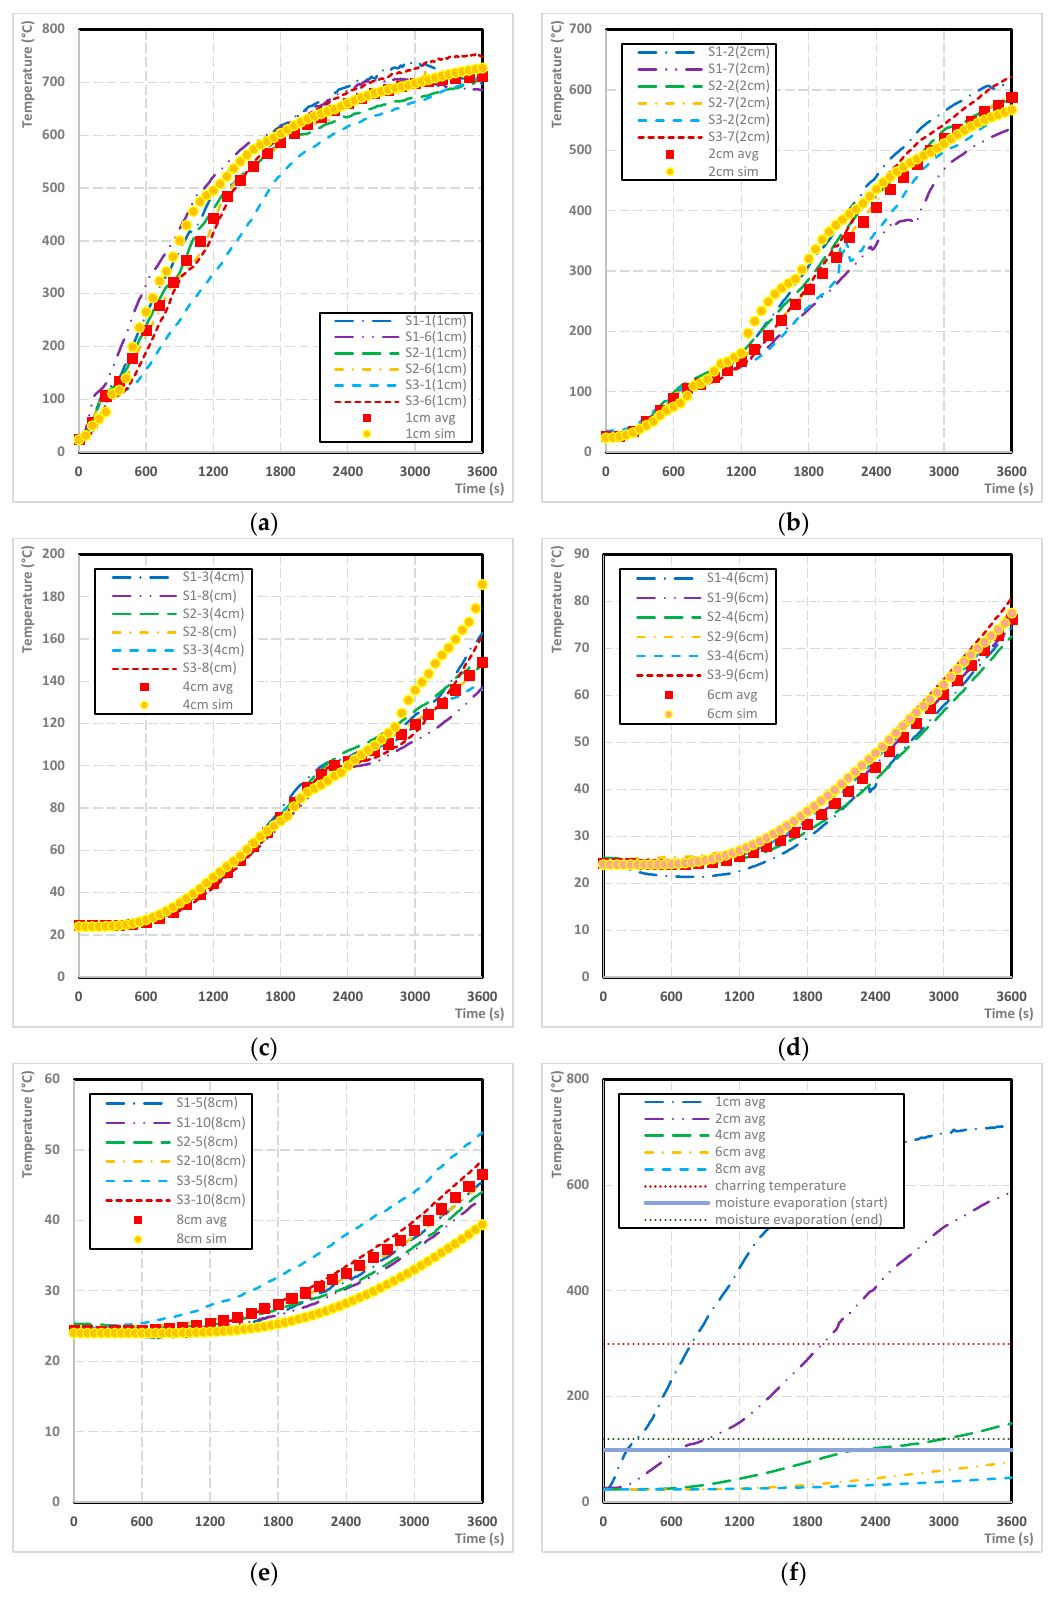
Figure 7. A comparison of temperature profiles—real test and simulation: ( a ) 1 cm depth, ( b ) 2 cm depth, ( c ) 4 cm depth, ( d ) 6 cm depth, ( e ) 8 cm depth, and ( f ) comparison of average temperature profiles.